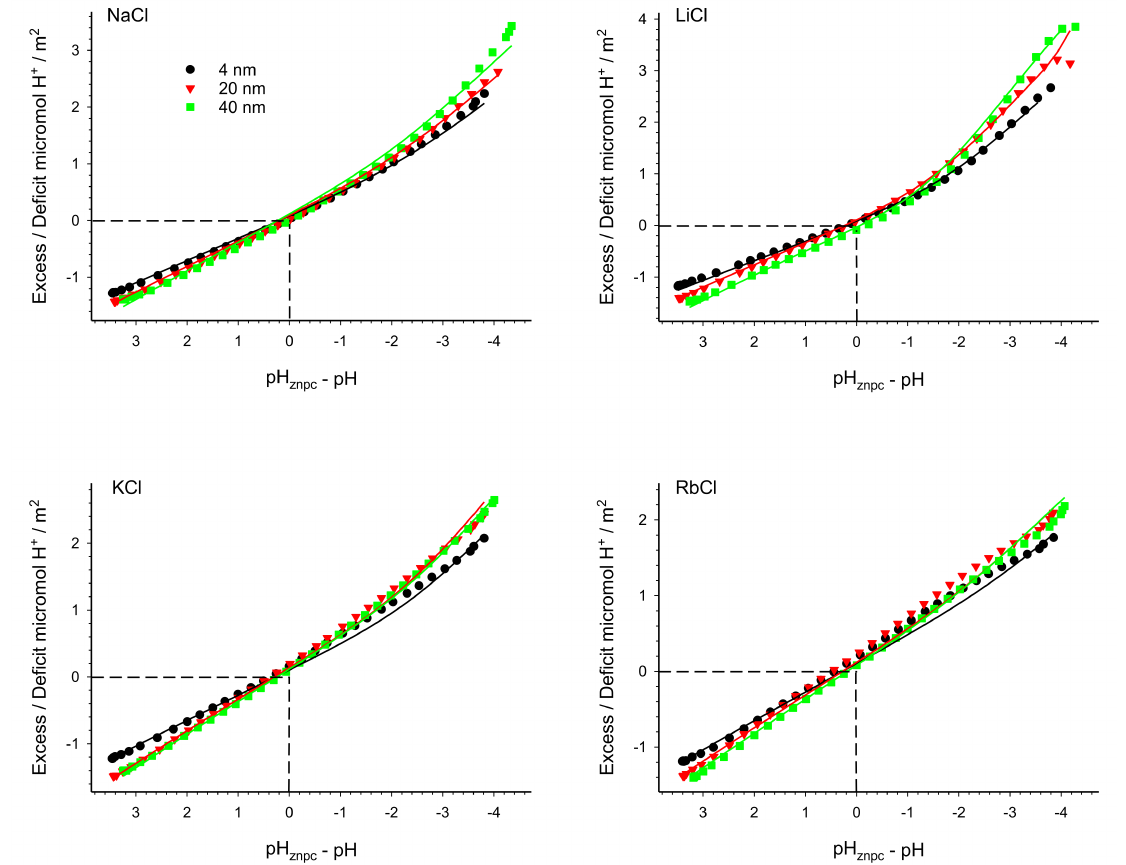
Figure 2. Titration data showing the effect of particle size on the relative proton adsorption or desorption as a function of pH znpc -pH. Data are presented for titrations at an ionic strength of 0.3 m, in NaCl, LiCl, KCl, and RbCl media. The symbols represent experimental data, and lines represent the SCM best